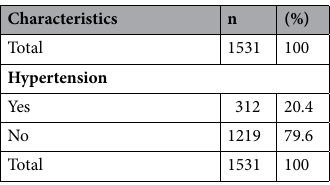
Table 2. Characteristics of the population of Gombe Matadi.